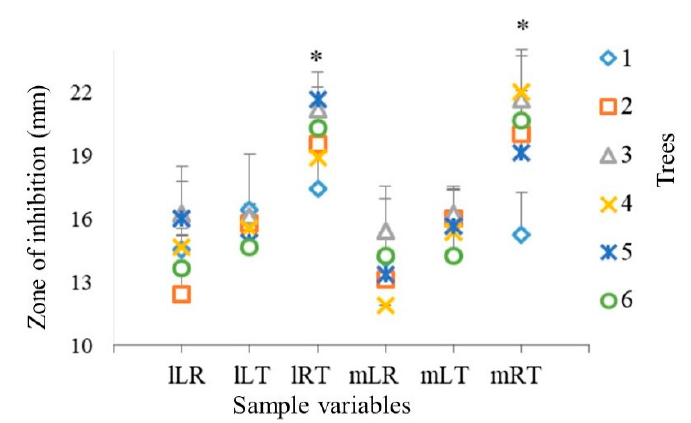
Figure 3. Effect cutting planes on the antimicrobial activity of 6 trees against Staphylococcus aureus . Y -axis is the value of zone of inhibition including the diameter of wooden discs (9.95 ± 0.1 mm); lLR = Laser cut radial plane samples; lLT = Laser cut tangential plane samples; lRT = Laser cut transversal plane samples; mLR = Manual cut radial plane samples; mLT = Manual cut tangential plane samples; mRT = Manual cut transversal plane samples; 1–6 number of trees; * p < 0.05.